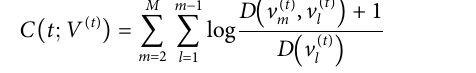
Frontiers in Computer Science |